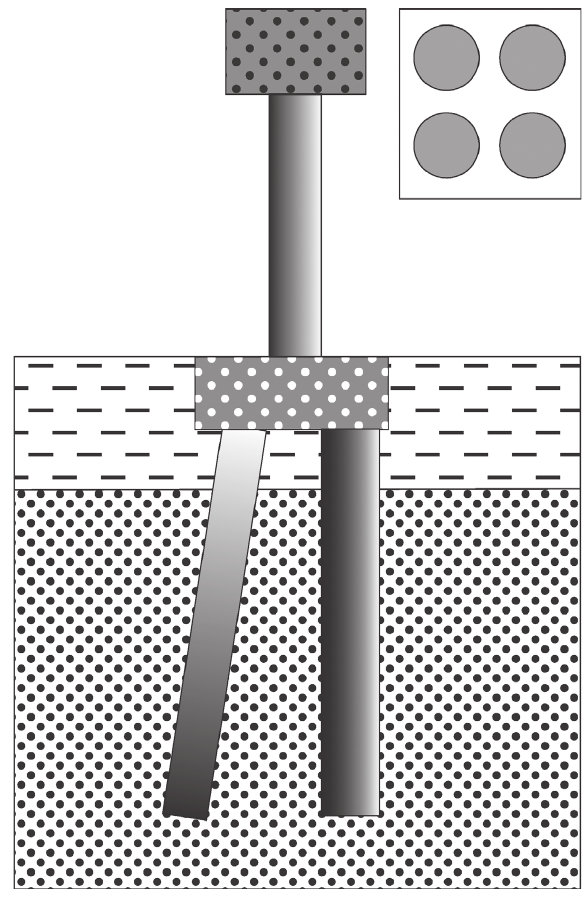
Figure 1: Schematic diagram of the model test of inclined and straight alternating pile groups with two layers of soil under low pile